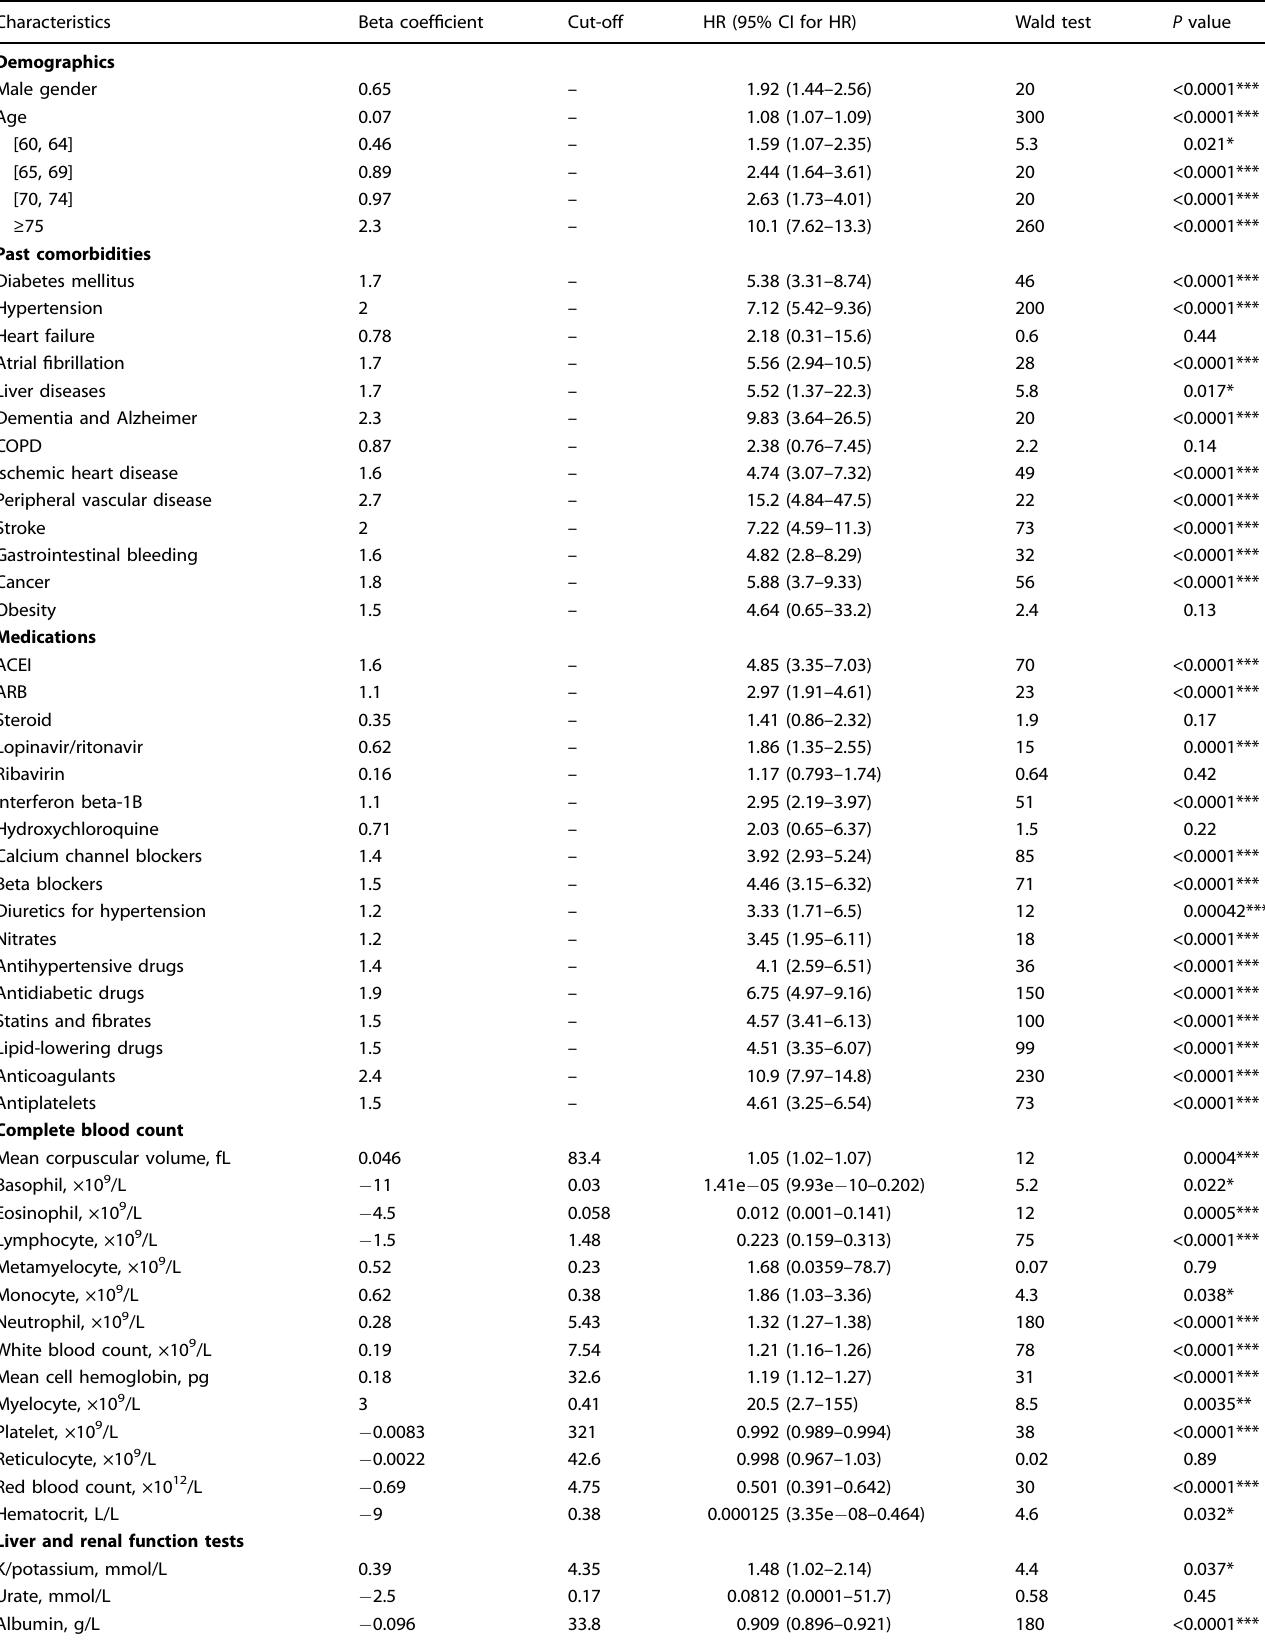
Table 2. Univariate analysis of signi fi cant risk factors to predict severe COVID-19 disease.